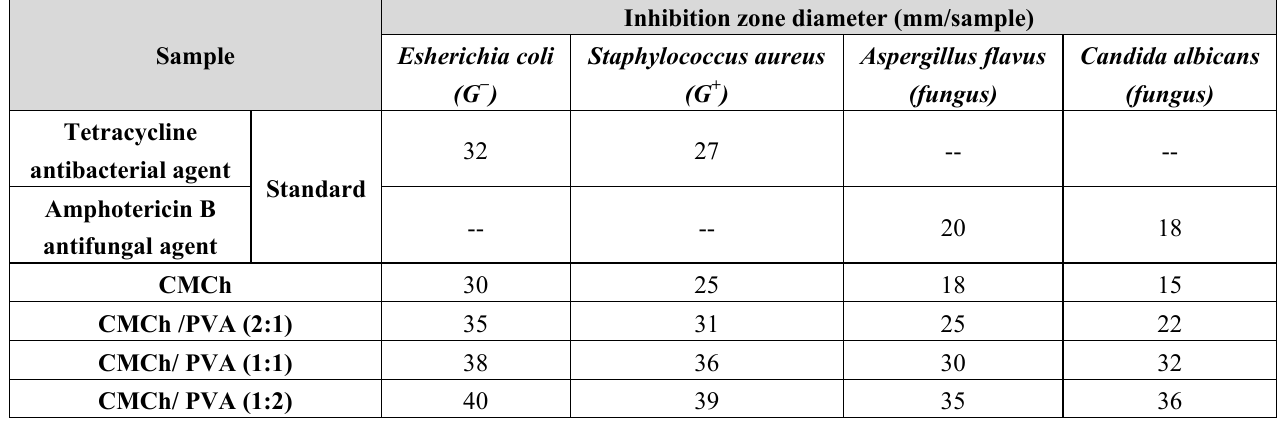
Table 1. Antimicrobial activity for the CMCh/PVA